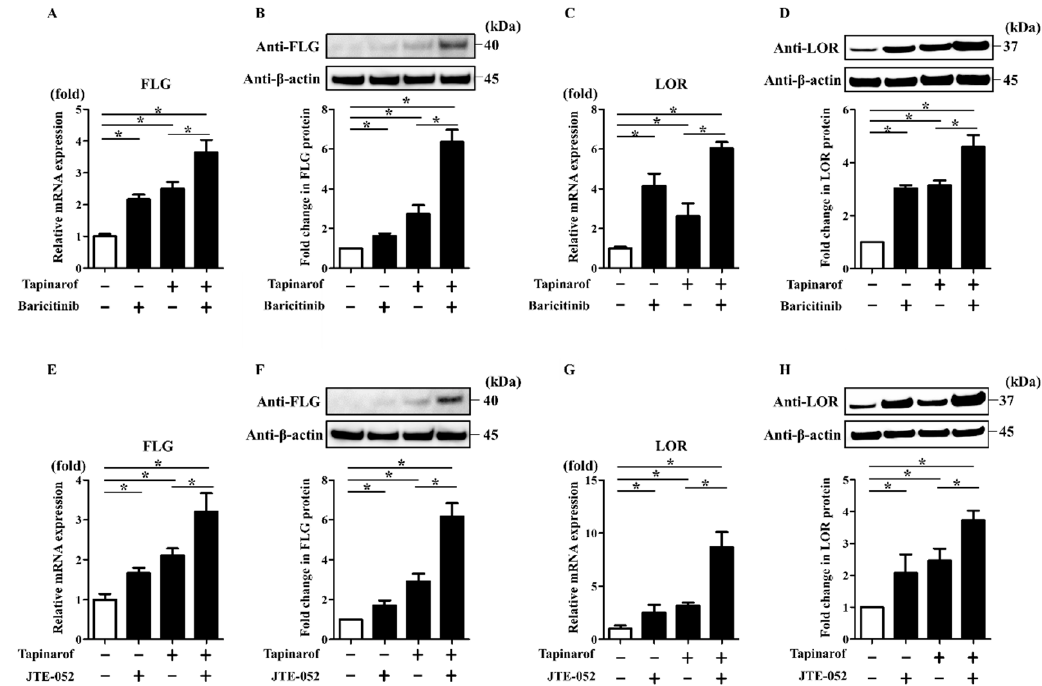
Figure 4. JAK inhibitors augmented tapinarof-induced upregulation of FLG and LOR expression in NHEKs. NHEKs were treated with baricitinib (1 µM) ( A – D ) or JTE-052 (1 µM) ( E – H ) in the presence or absence of tapinarof (500 nM) for 72 h for qRT-PCR and for 96 h for Western blotting analyses. ( A , C , E , G ) FLG and LOR mRNA expression was assessed by qRT-PCR. Representative data of three independent experiments with similar results are shown. ( B , D , F , H ) FLG and LOR protein expression was analyzed by Western blotting with anti-FLG and anti-LOR antibodies. ( Upper ) Representative blot images of three independent experiments with similar results are shown. ( Lower ) FLG or LOR protein levels are normalized to β -actin protein levels using ImageJ and expressed as fold change over the control group. ( A – H ) Error bars represent mean ± standard deviation; n = 3 for each group. Statistically significant di ff erences are presented: * p <